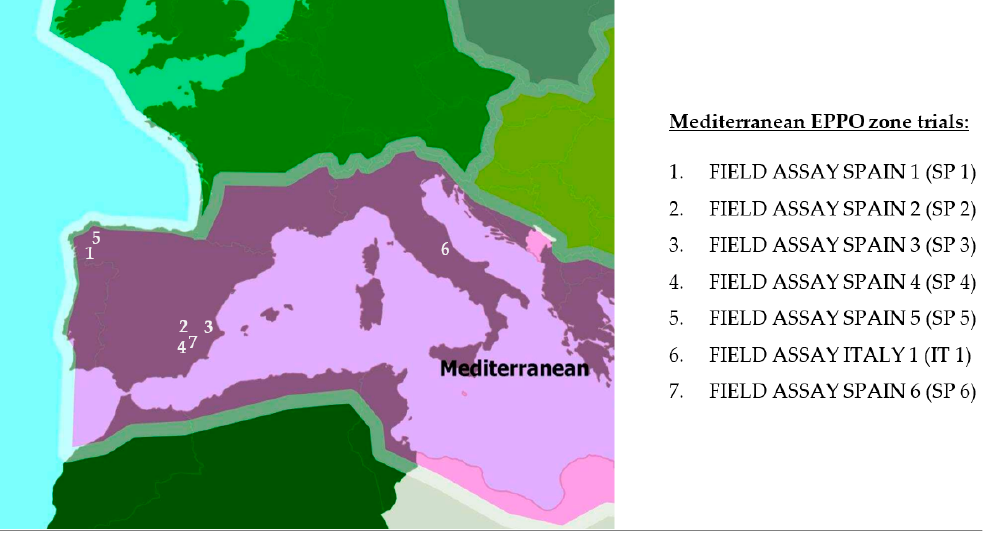
Figure 2 . Zones of comparable climate in the European and Mediterranean Plant Protection Organization (EPPO) region as defined in EPPO Standard PP 1/241 Guidance on comparable climates for the purposes of efficacy evaluation trials on plant protection products. The borders are intentionally broad, indicating that there is an area of gradual change in climate between the zones proposed. Numbers in the map indicates the trial location. Table 3. Trial conditions in each field trial. All trials lasted 30 days.